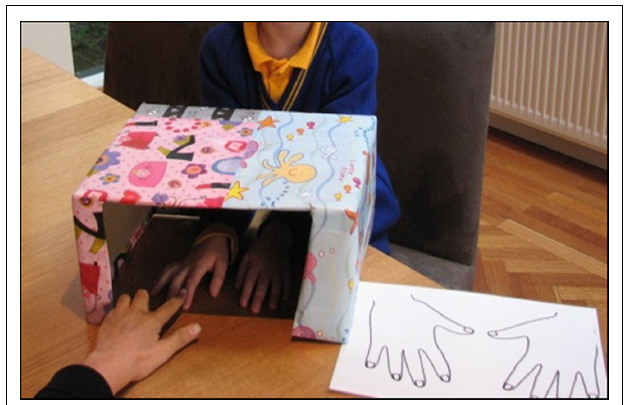
FIGURE 1 |The non-motoric finger gnosia test apparatus.